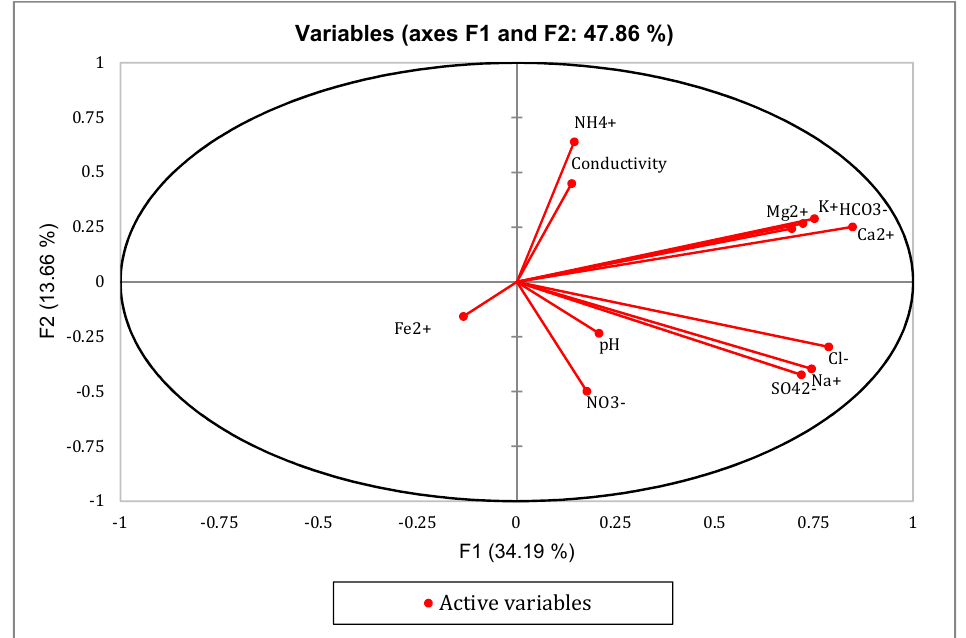
Figure 9. Correlation circle.